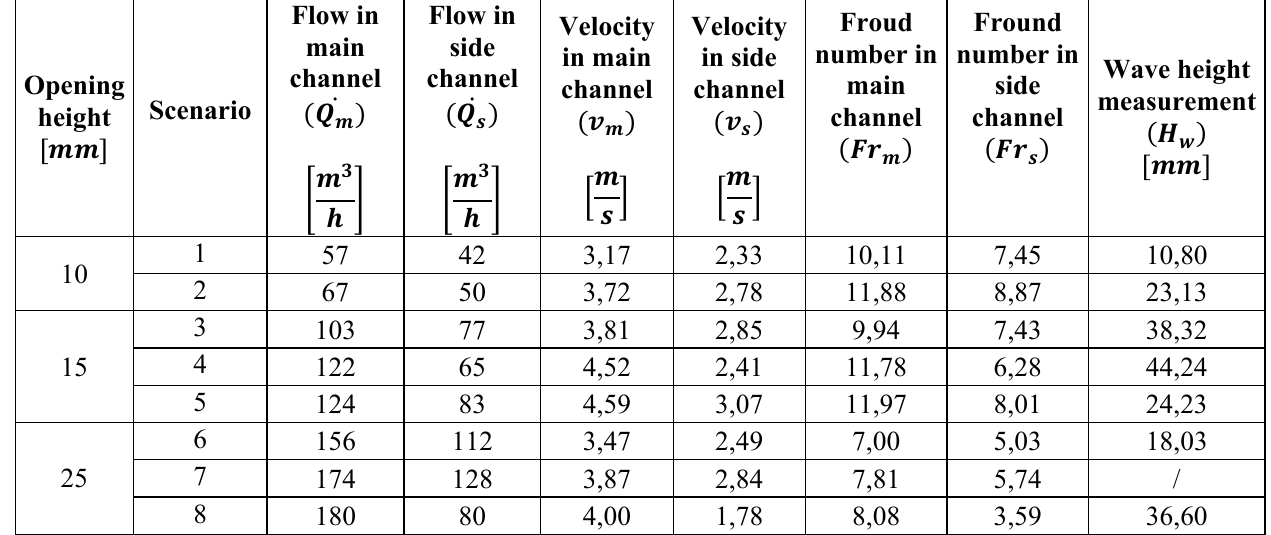
Table 2: Parameters of all scenarios with measured turbulent flow heights